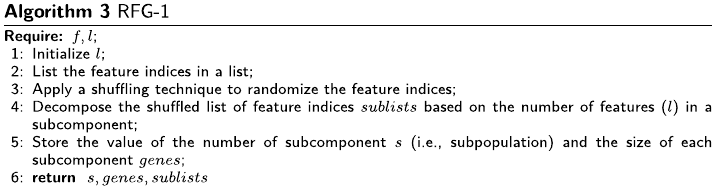
Algorithm 3 is the pseudocode of the proposed random feature grouping technique